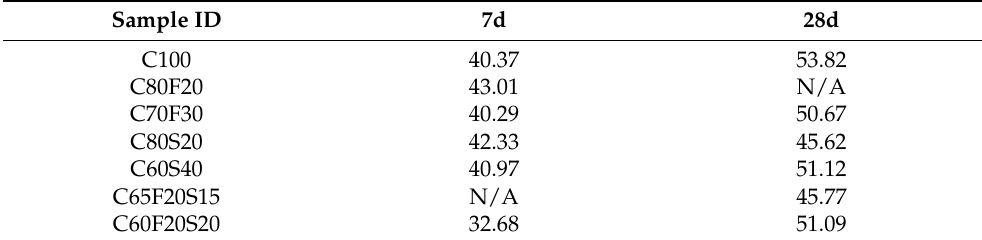
Table 3. Elastic modulus of concrete (GPa).